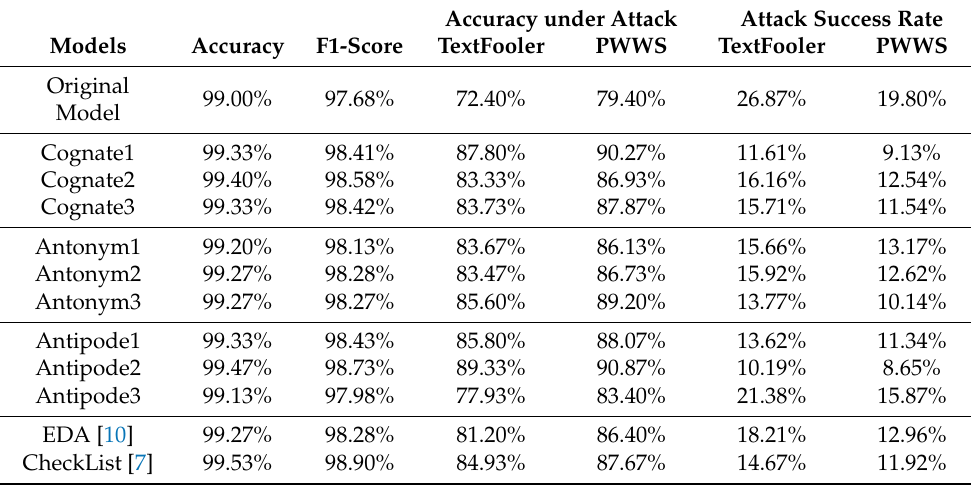
Table A4. SMS-Spam Performance and Robustness